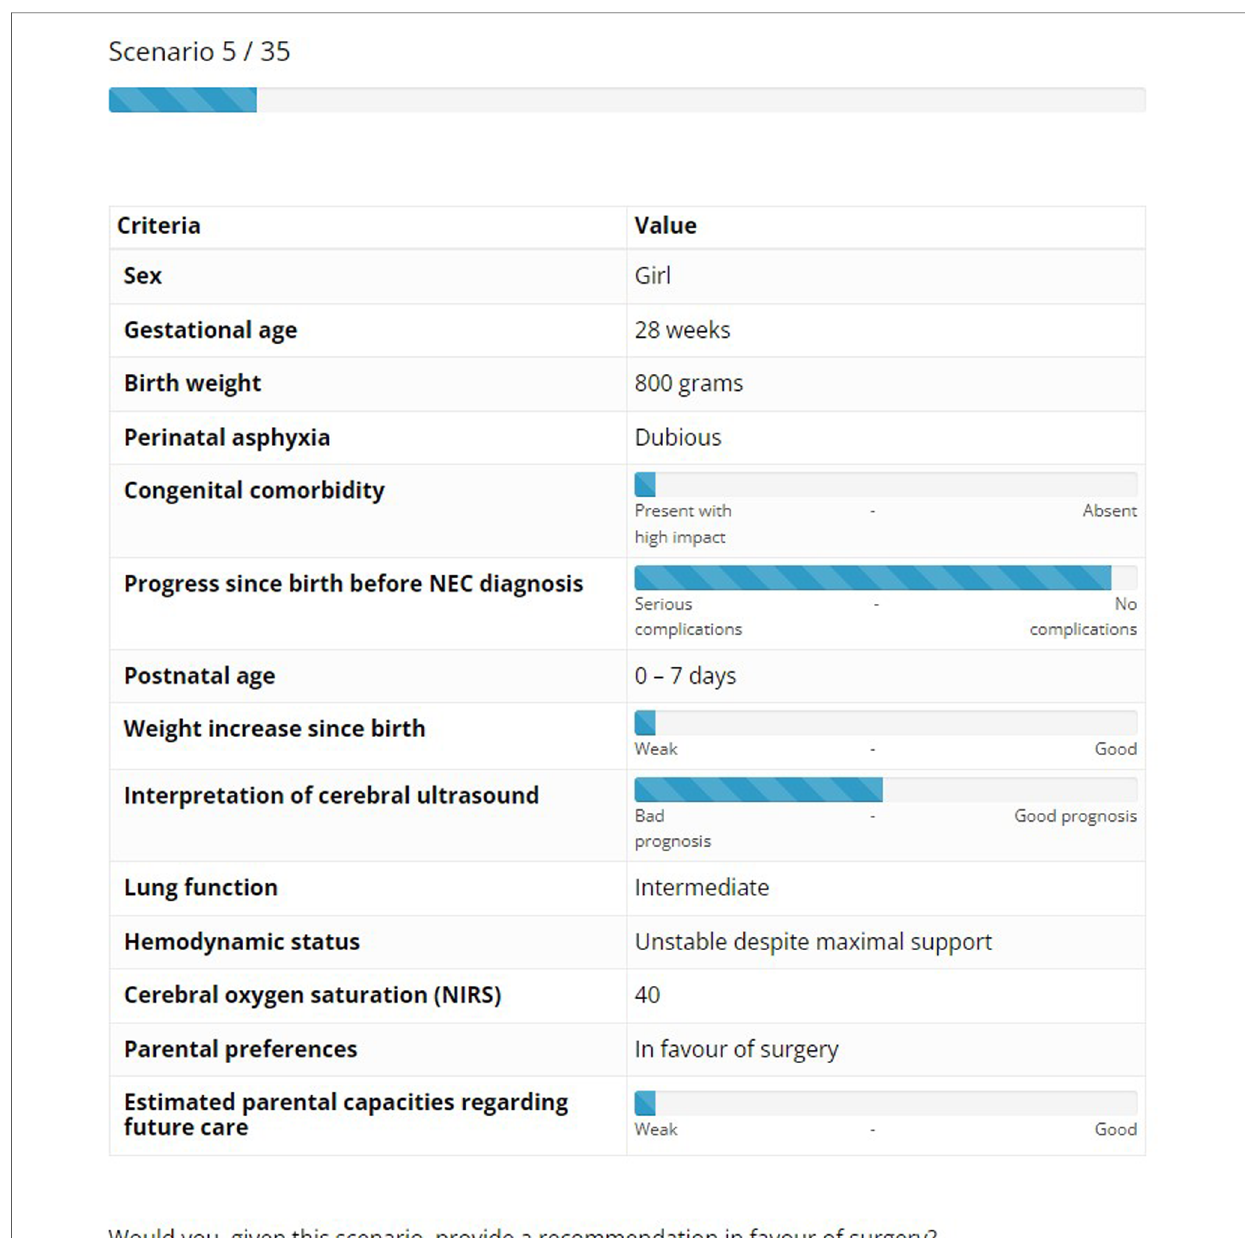
FIGURE 1 Example of a choice scenario as completed by